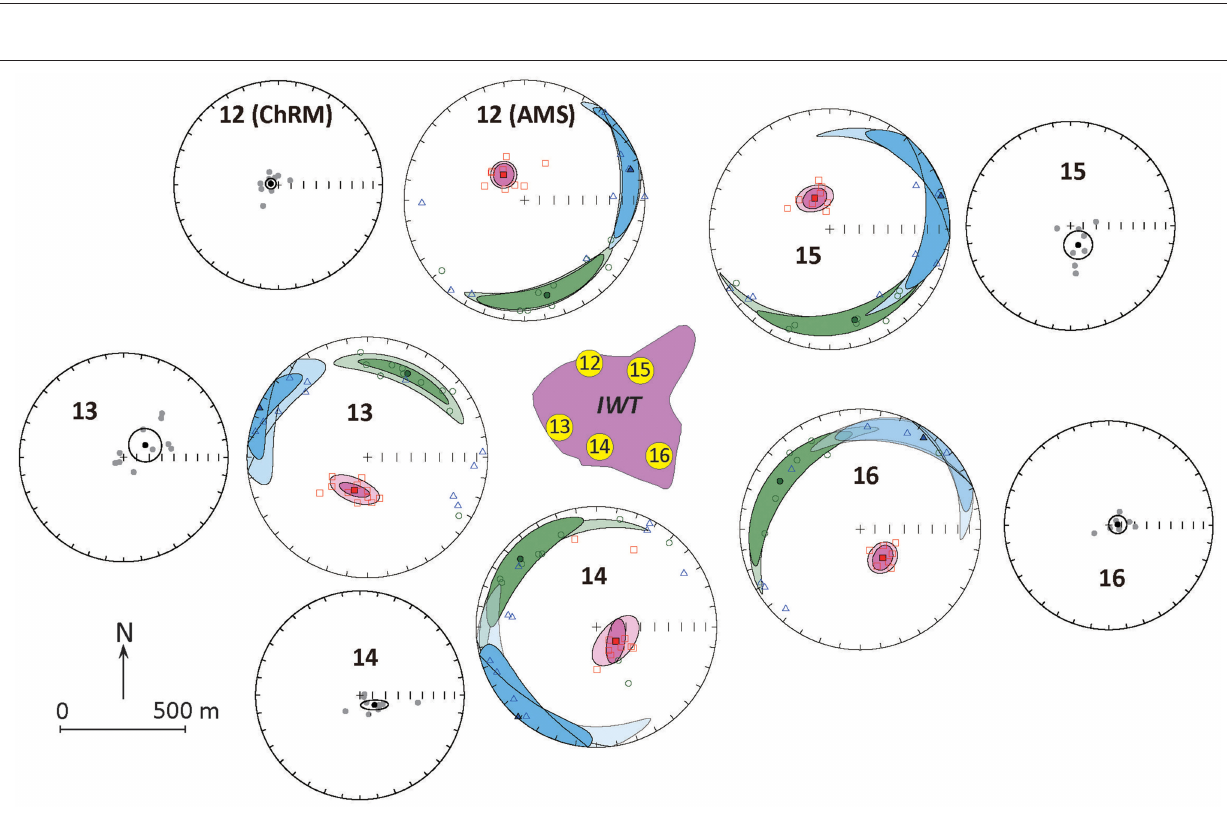
FIGURE 5 | (A) Examples of normalized isothermal remanent magnetization (IRM) acquisition and the back-field demagnetization curves. For 22 and 29K, a gradual increase of magnetization up to 300mT in IRM acquisition with ∼ 100mT of remanent coercivity was observed. A rapid increase of magnetization during acquisition of IRM and a quick decay of IRM during back-field demagnetization was observed for 26 and 27K. For 27L and 27M, the saturation was not achieved up to a maximum field of 1T, and the remanence coercivity was > 300mT. (B) Hysteresis data in a Day plot (Day et al., 1977) with the single-domain and multidomain mixing trend curves (Dunlop, 2002).